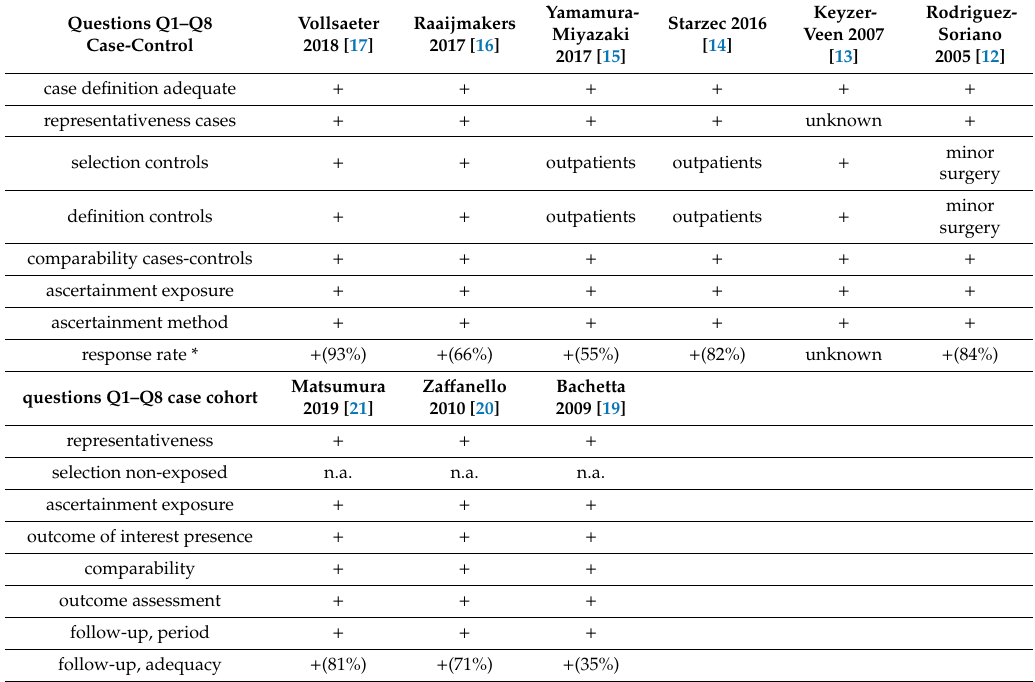
Table 3. The Newcastle–Ottawa quality assessment scale applied to the studies retained in this